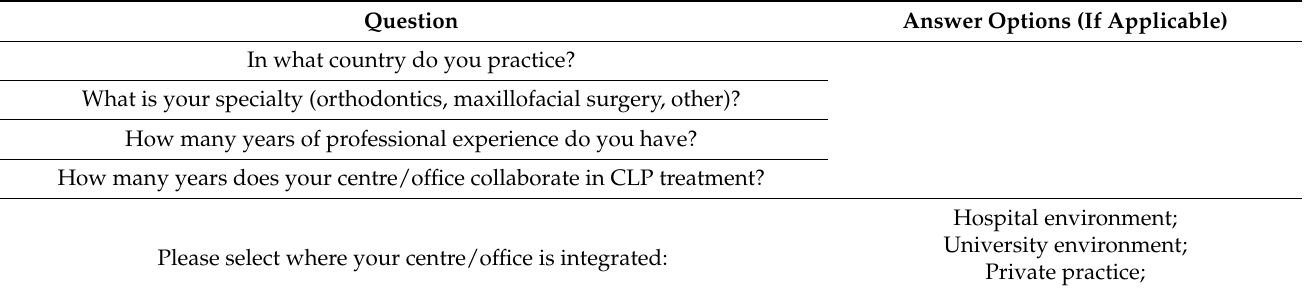
Table A1. Survey questions and answers